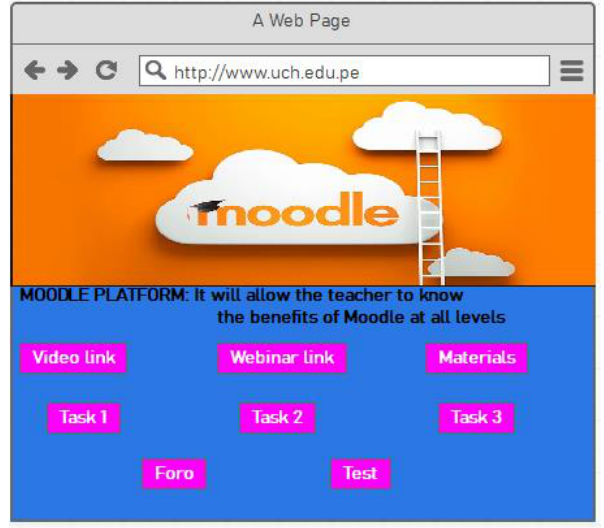
Fig. 11. General presentation of the Moodle